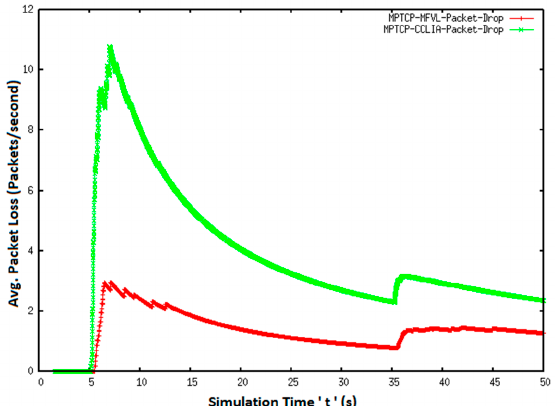
Figure 18. Average packet drop rate with CBR data rate of 2 Mbps.